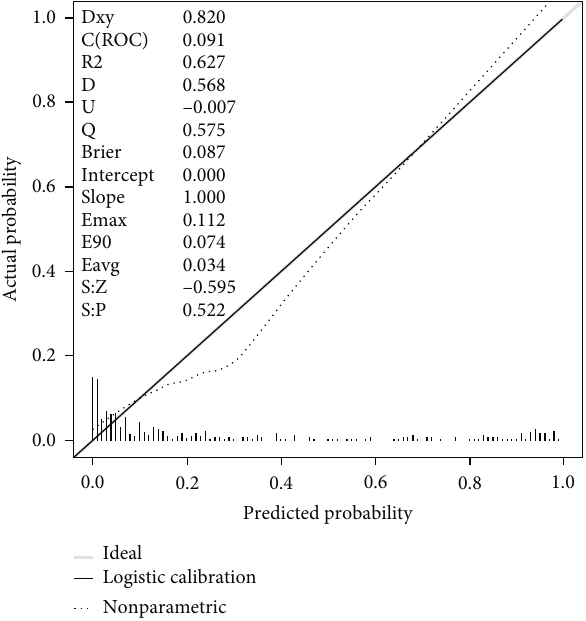
Figure 4: Nomogram model for predicting the risk of recurrence after POP surgery.